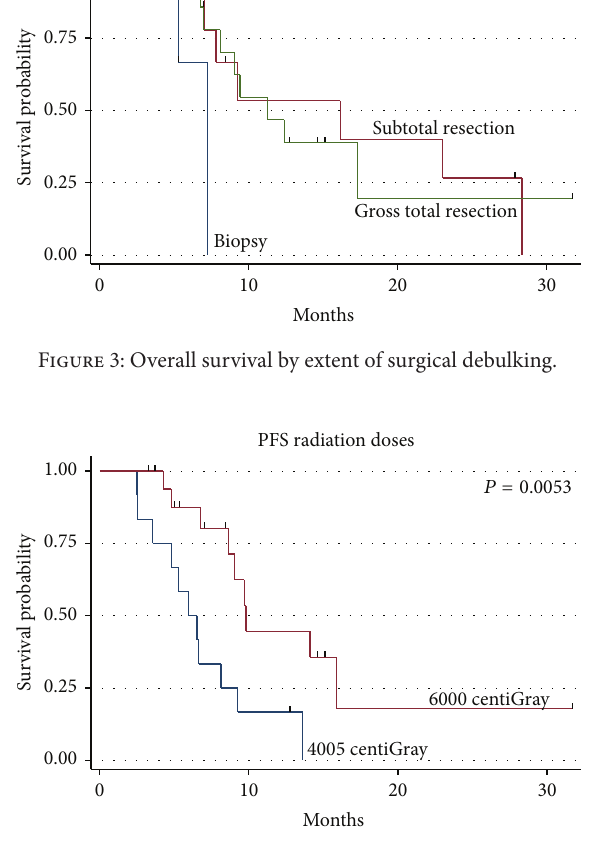
Figure 4: Progression-free survival by radiation